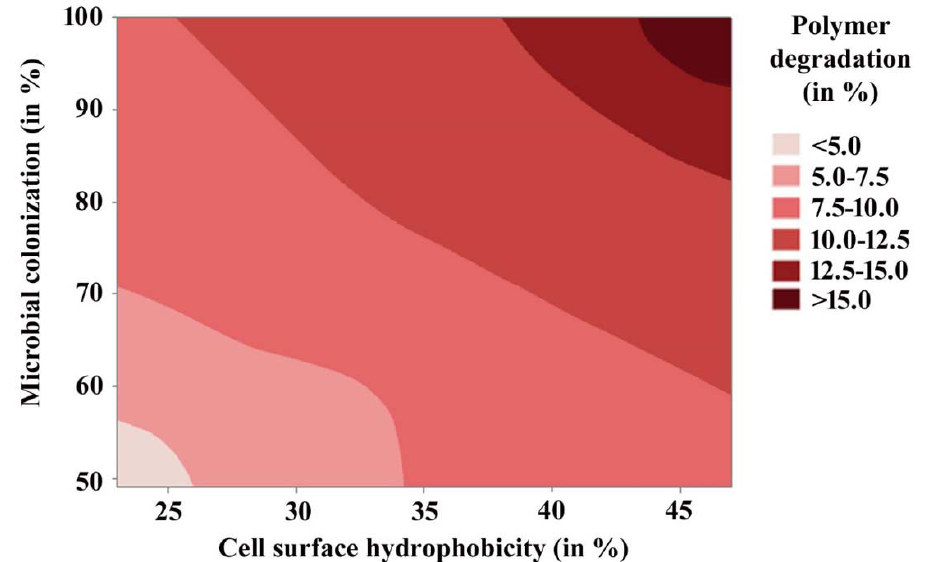
Fig. 4. Relationship among cell-surface hydrophobicity, microbial colonization, and polymer degradation was established by constructing a contour plot using Minitab 19 software. Different colors represented different degrees of LDPE